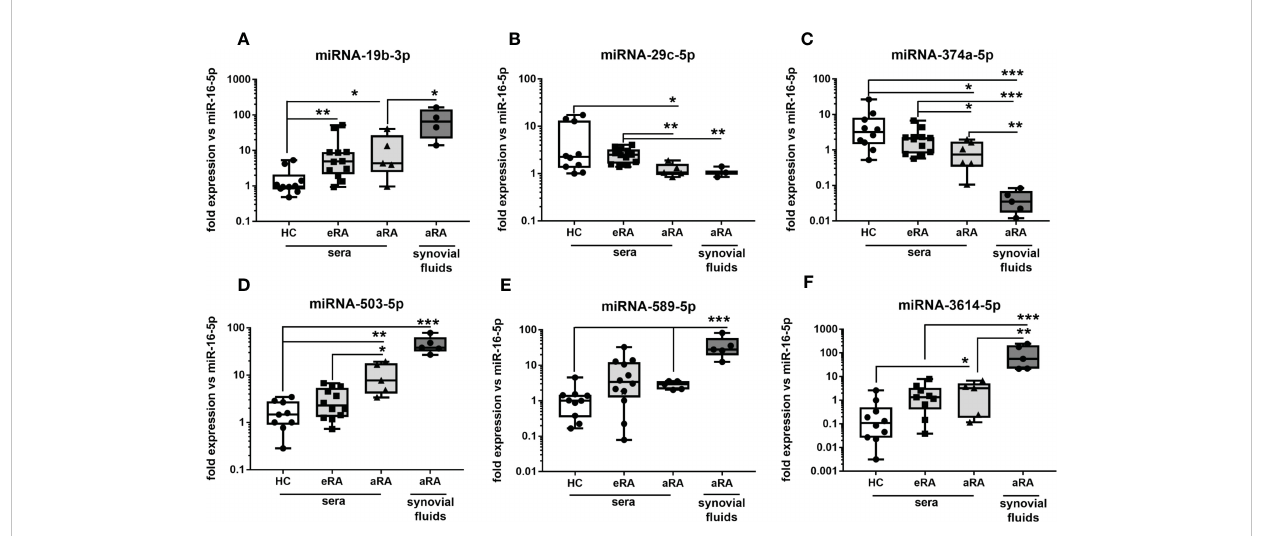
FIGURE 3 The levels of circulating miRNA in body fl uids of eRA and aRA patients. The levels of miRNA-19b-3p (A) , miRNA-29c-5p (B) , miRNA-374a-5p (C) , miRNA-503-5p (D) , miRNA-589-5p (E) , miRNA-3614-5p (F) in sera or eRA and aRA and SF of aRA patients compared to HC. P-values were expressed as follows: ns for not signi fi cant; 0.05 > P > 0.01 as *; 0.01 > P > 0.001 as **; P < 0.001 as ***, P <0.0001 as